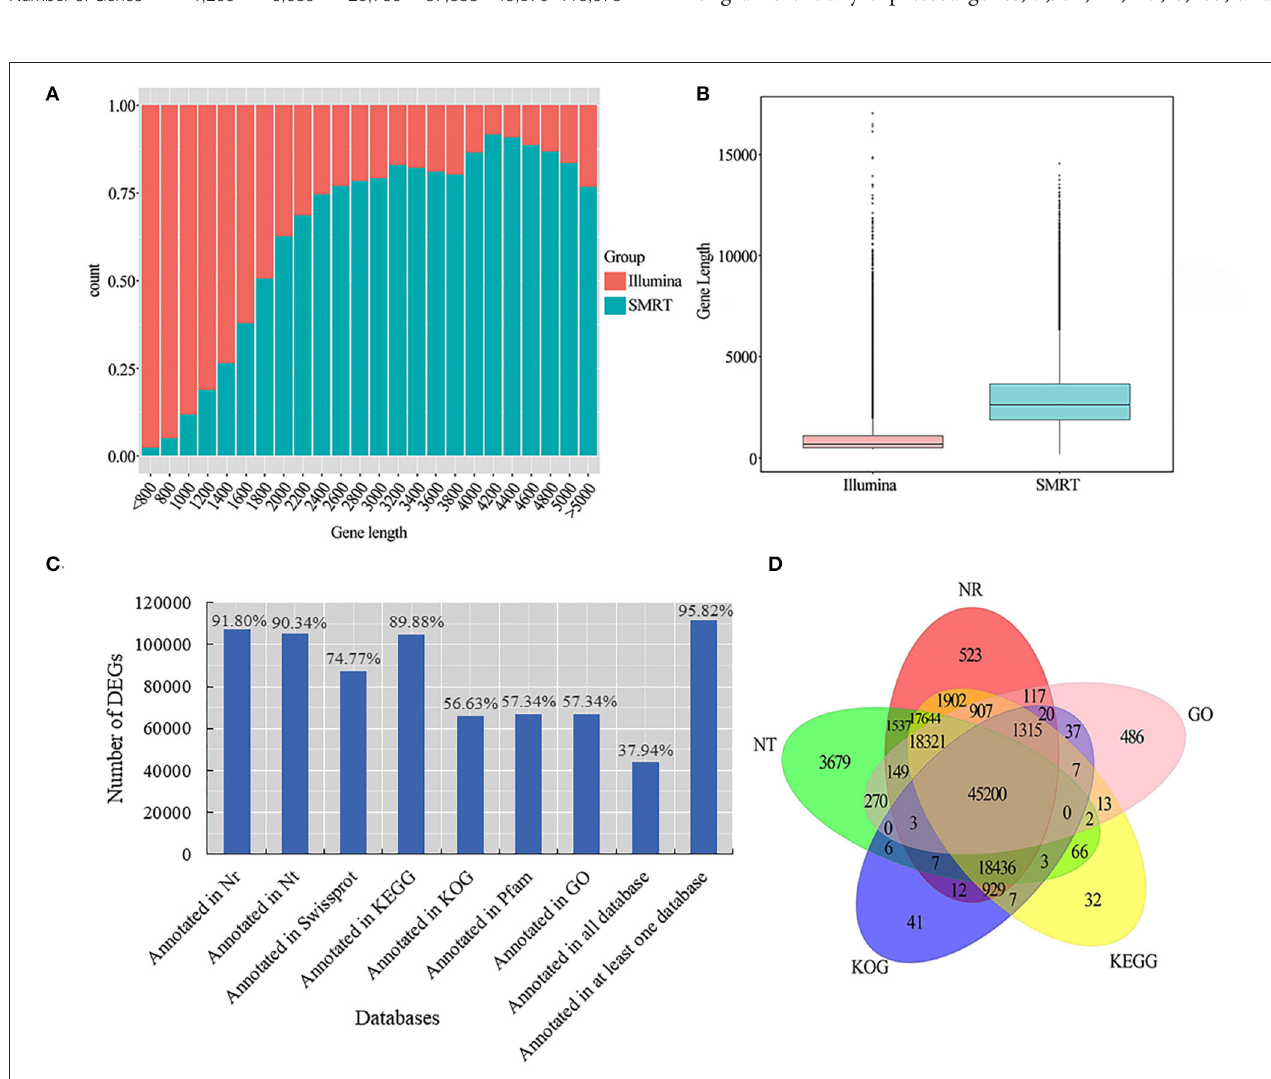
FIGURE 2 | Unigene length distribution map and gene function annotation Venn diagram. (A) Illumina and SMRT measured the gene count distribution map. The abscissa is the length (nt) of the predicted gene; the ordinate is the number of transcripts reads of the gene; (B) Illumina and SMRT measured gene length distribution box diagram; (C) seven database annotation results statistical graph; (D) gene function annotation Venn diagram.